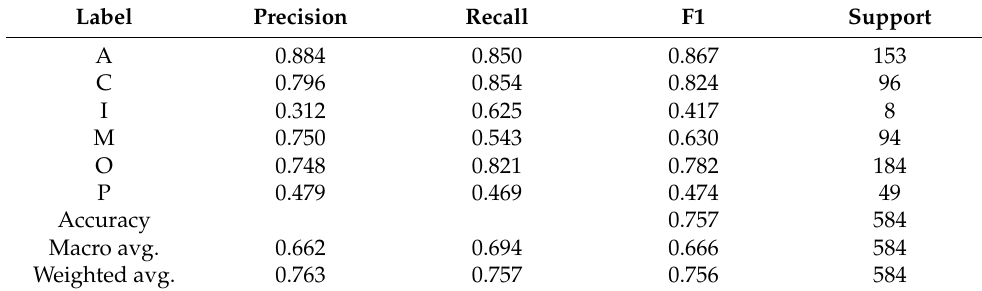
Table 1. Performance of the PICO classification (Section 3.2) on a dataset of 50 Embase abstracts related to the pre-exposure prophylaxis for